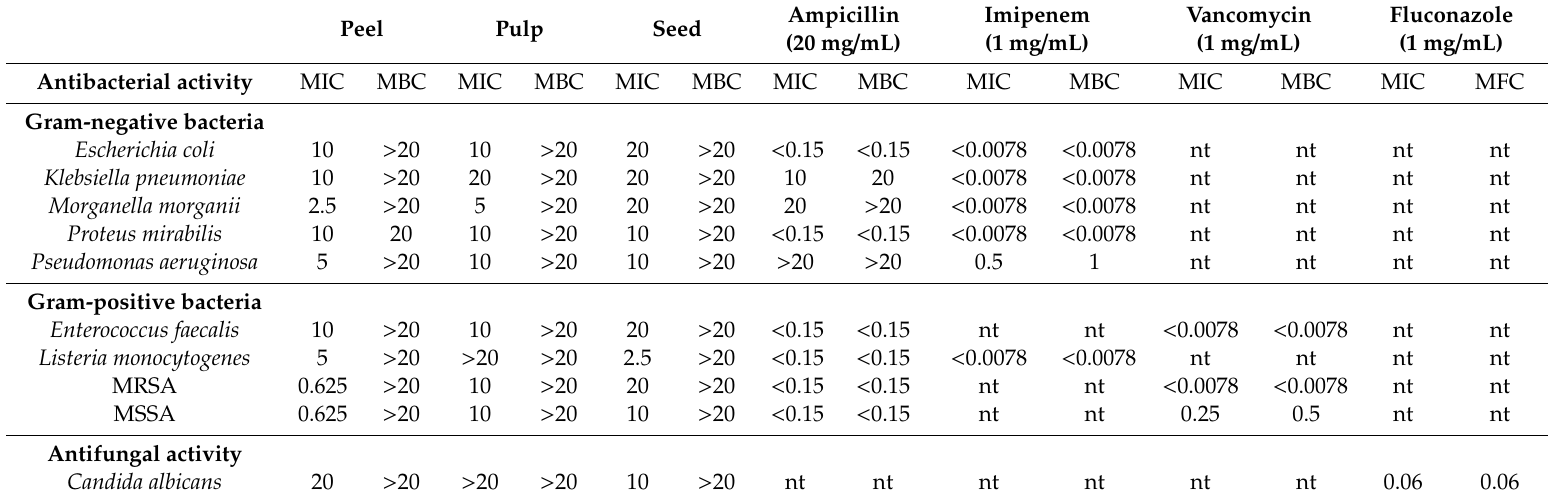
Table 2. Antimicrobial potentials of the distinct camu-camu ethanolic extracts (peel, pulp, and seed). Ampicillin Imipenem Vancomycin Fluconazole Peel Pulp Seed (20 mg / mL) (1 mg / mL) (1 mg / mL) (1 mg / mL) Antibacterial activity MIC MBC MIC MBC MIC MBC MIC MBC Gram-negative bacteria 10 > 20 nt Klebsiella pneumoniae 10 > 20 20 > 20 20 > 20 nt nt Proteus mirabilis 10 20 10 > 20 10 > 20 nt Pseudomonas aeruginosa 5 > 20 nt nt nt nt Gram-positive bacteria Enterococcus faecalis 10 > 20 10 > 20 20 nt nt Listeria monocytogenes 5 > 20 > 20 < 0.15 < 0.0078 < 0.0078 nt nt nt nt MRSA 0.625 > 20 10 nt MSSA 0.625 > 20 nt Antifungal activity Candida albicans 20 > 20 >